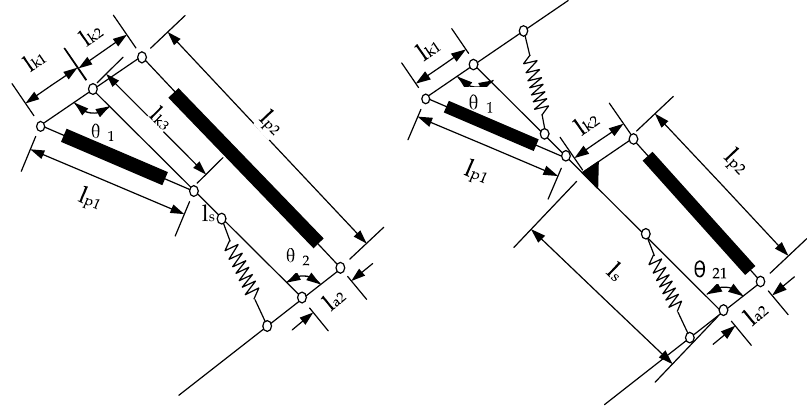
Figure 3. Sketch of the bionic leg structure.